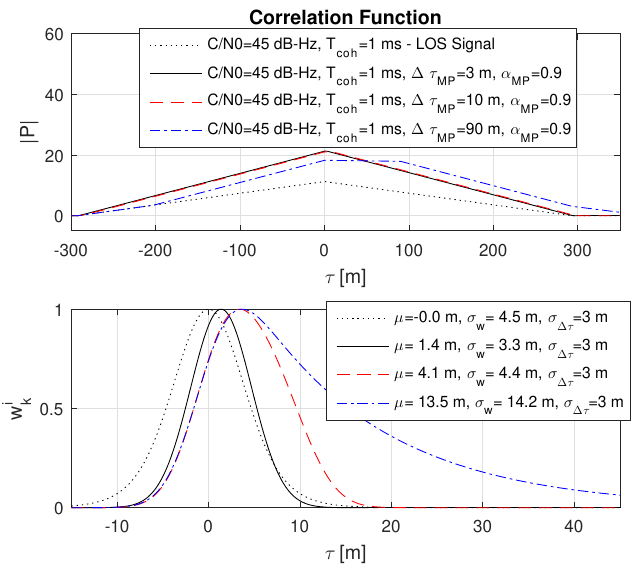
Figure 10. Impact of different multipath offsets ∆ τ MP on the probability function. For a better visualization, a strong relative multipath to the LOS signal with α MP = 0.9 is chosen. It can be seen that higher offsets increase the weighted mean µ but do not necessarily increase the weighted standard deviation σ w . The dotted black line refers to the LOS